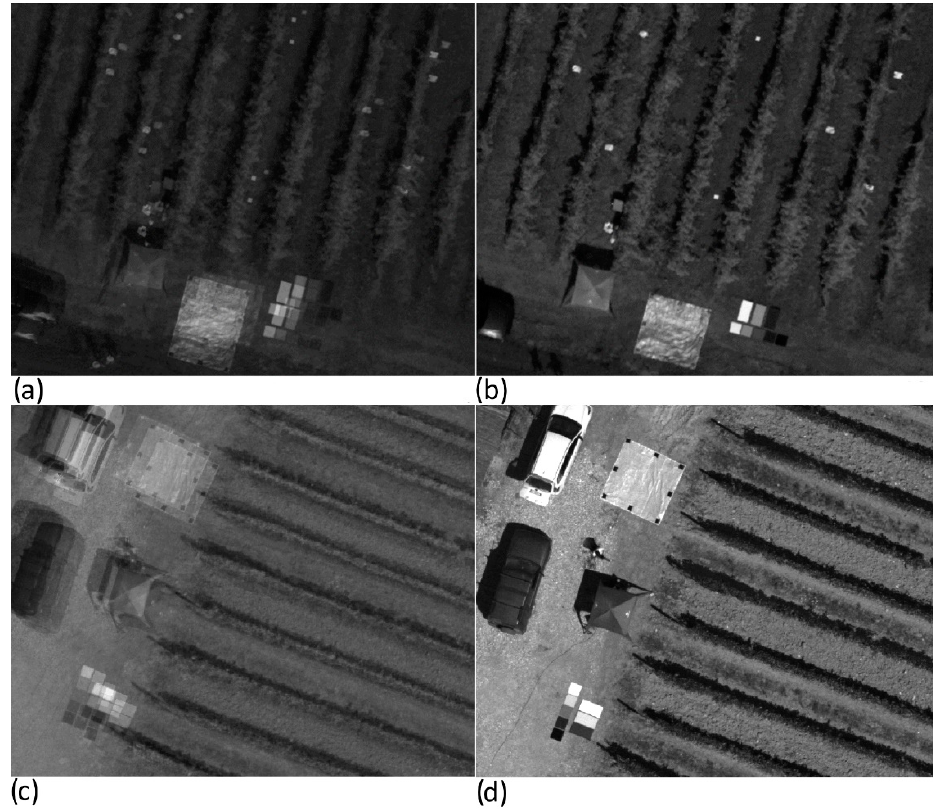
Figure 22. Details of three bands composite results for Piancenza ( a , b ) and Chianti ( c , d ) study areas: ( a , c ) unmatched band composite using the original mosaics showed in Figure 21; ( b , d ) using the three bands’ mosaics after the georeferencing procedure in QGIS software.